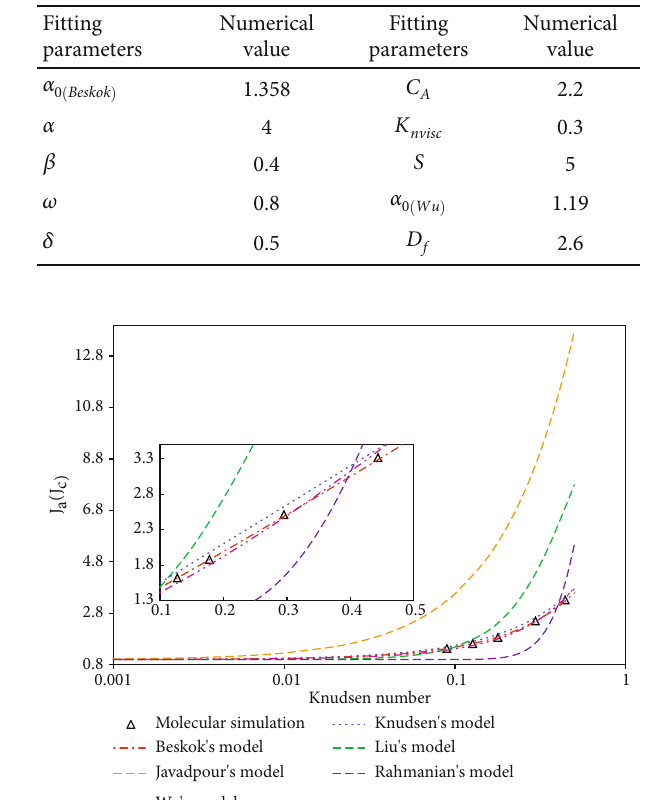
Table 1: The fi tting parameters used in the calculation.